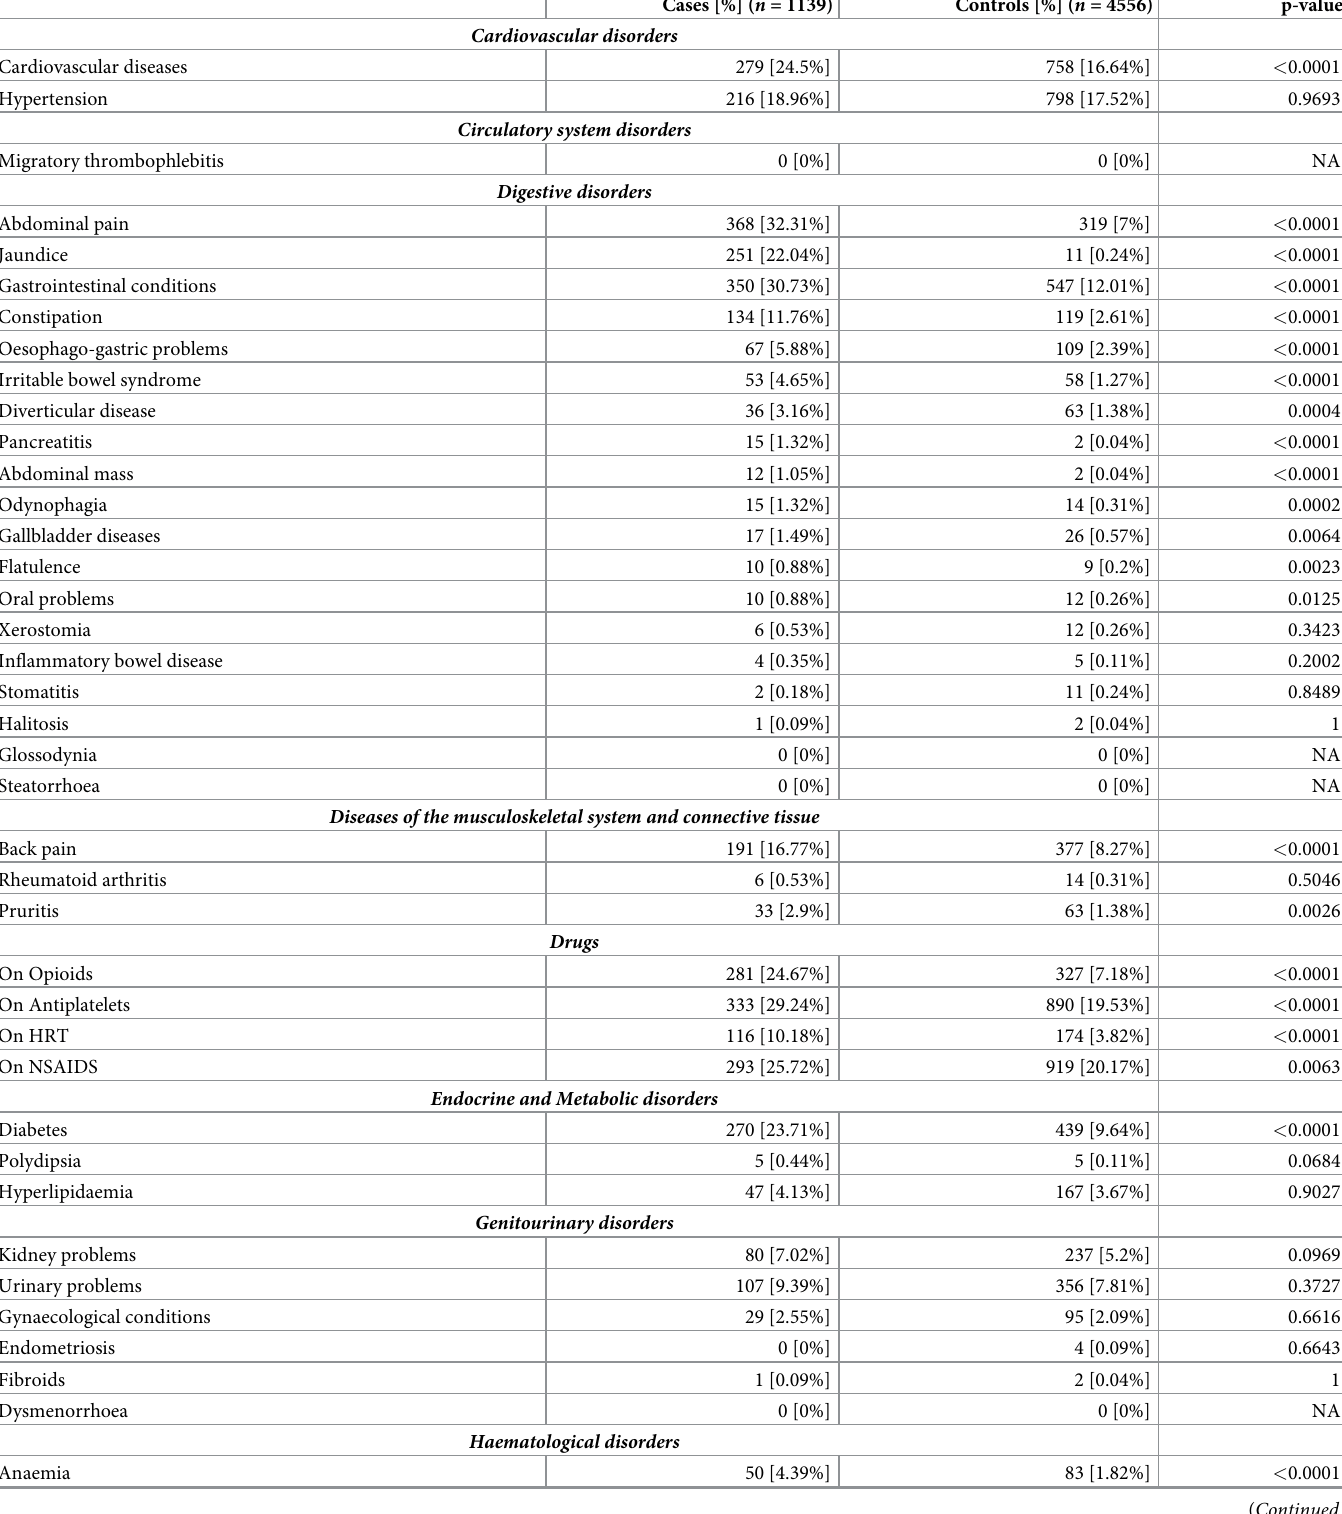
Table 1. Percentage of cases and controls reporting symptoms or statuses within the 24-month period prior to